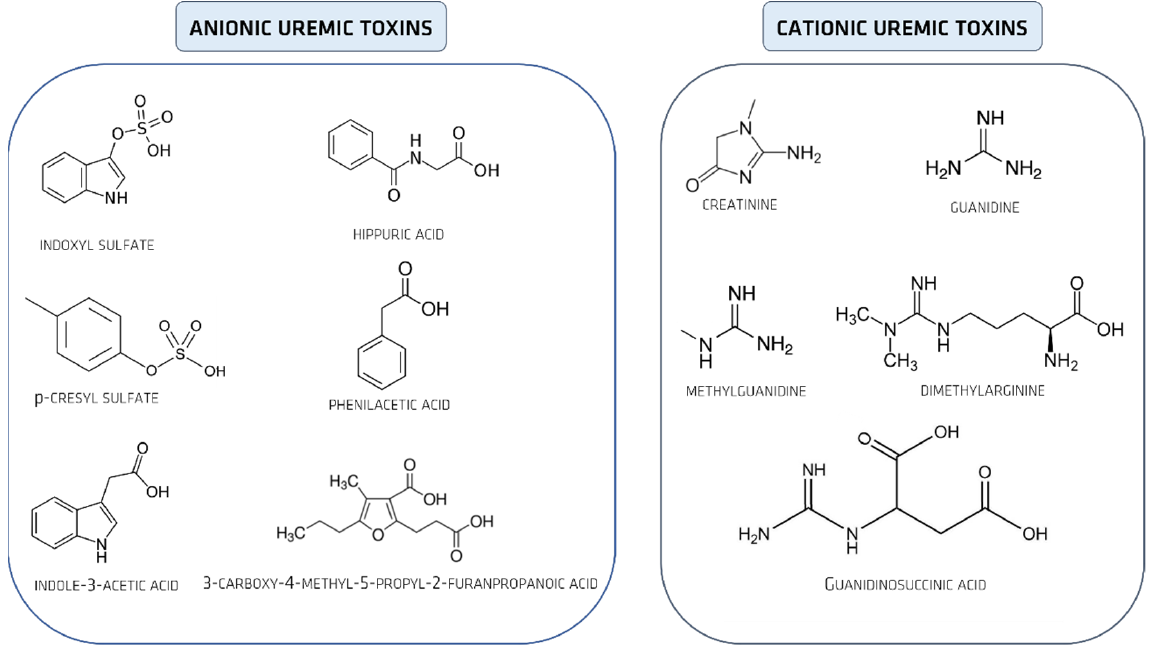
Figure 2. Chemical structures of anionic and cationic UTs (adapted from [6]).